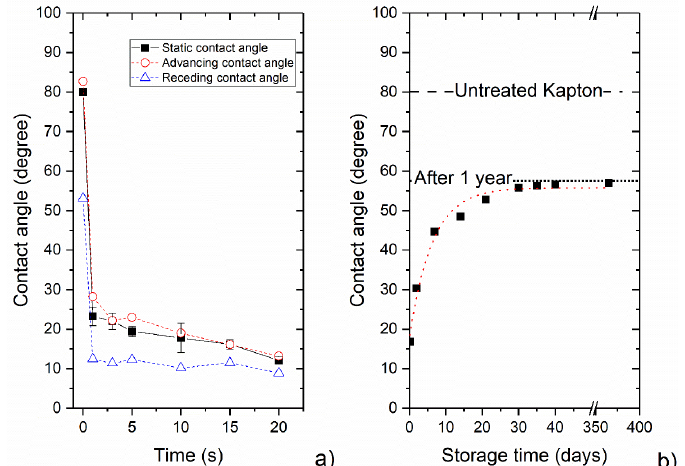
Figure 4. ( a ) Static and dynamic water contact angles in dependence on the duration of the DBD treatment of Kapton and ( b ) evolution of the water contact angle with the storage time (treatment duration 10 s).